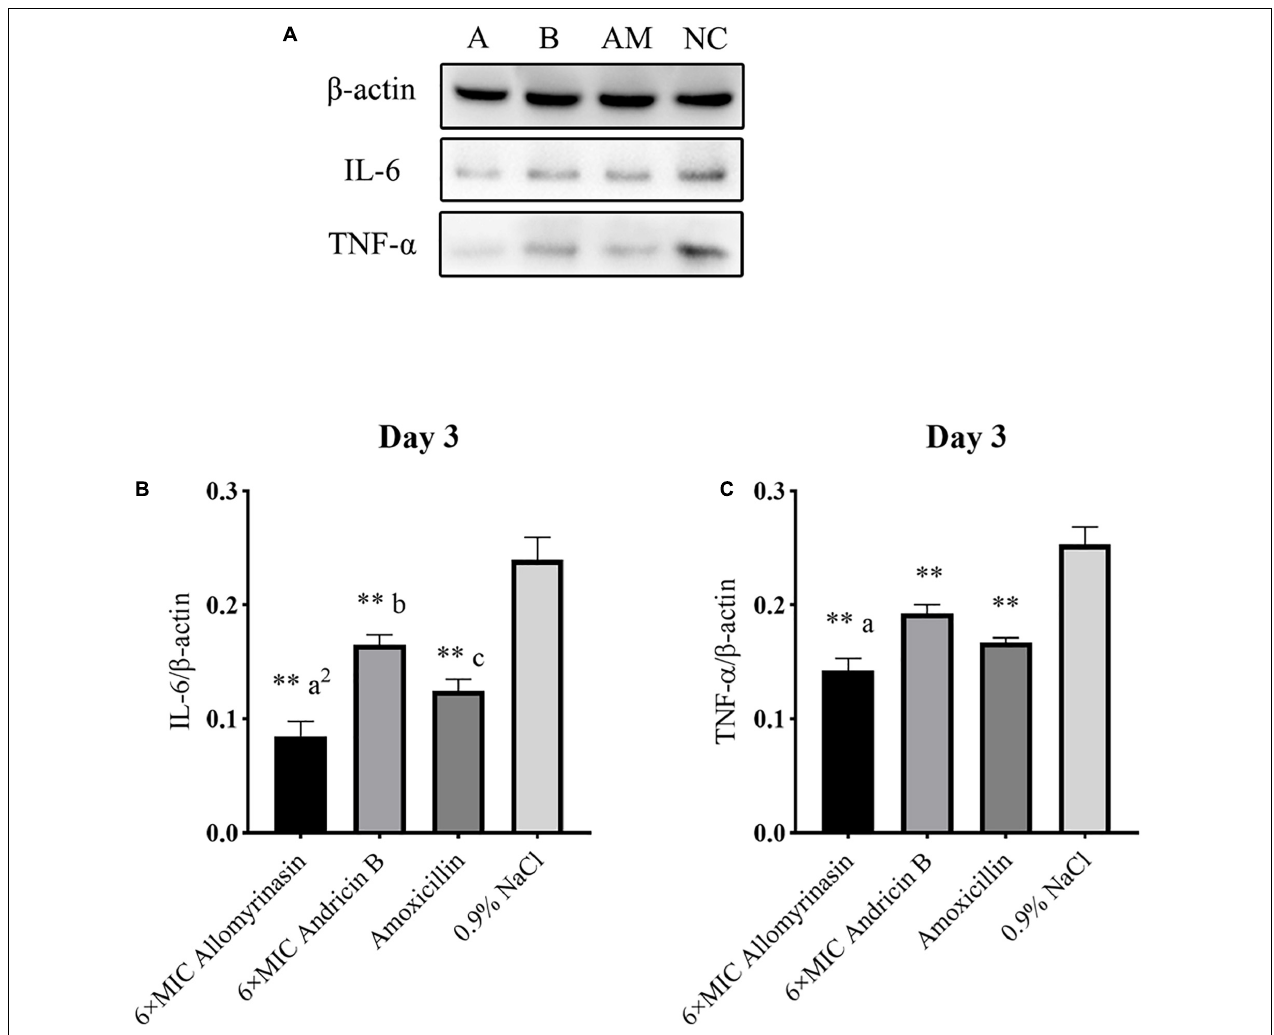
FIGURE 12 | Allomyrinasin inhibited the proinflammatory cytokines IL-6 and TNF- α on day 3 after skin infections induced by Staphylococcus pseudintermedius MW767056. (A) Western blotting analysis of IL-6 and TNF- α expression in the skin tissues of mice. (B,C) Expression of IL-6 and TNF- α , with β -actin as the internal control, in the infected skin is presented in bar graphs. Data with error bars are presented as the mean ± SD ( n = 3). (A) 6 × minimal inhibitory concentration (MIC) allomyrinasin. (B) 6 × MIC andricin B. AM, amoxicillin; NC, 0.9% NaCl. * p < 0.05, ** p < 0.01, compared with saline group; a p < 0.05, a2 p < 0.01, compared with group treated with andricin B; b p < 0.05, b2 p < 0.01, compared with group treated with